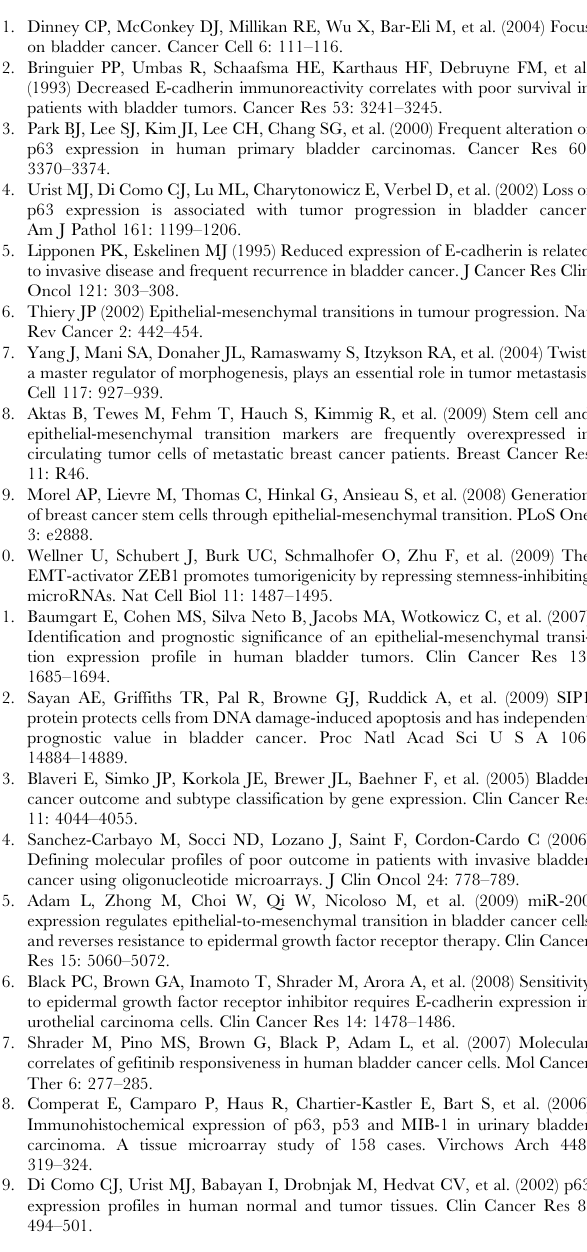
Figure S1 EMT marker expression in primary bladder tumors was measured by quantitative real-time PCR and stratified